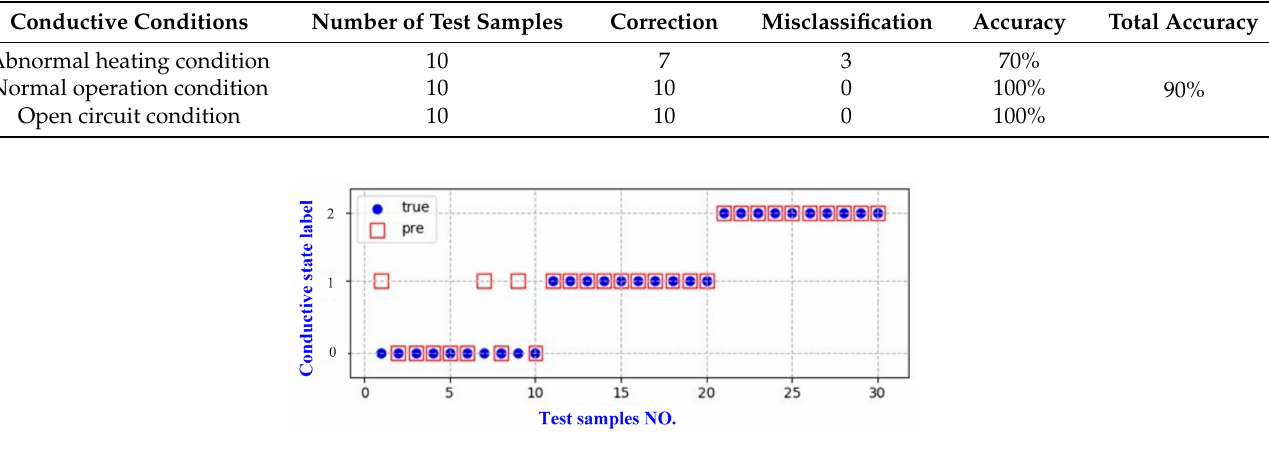
Figure 16. The classification results of the models using the test sets.